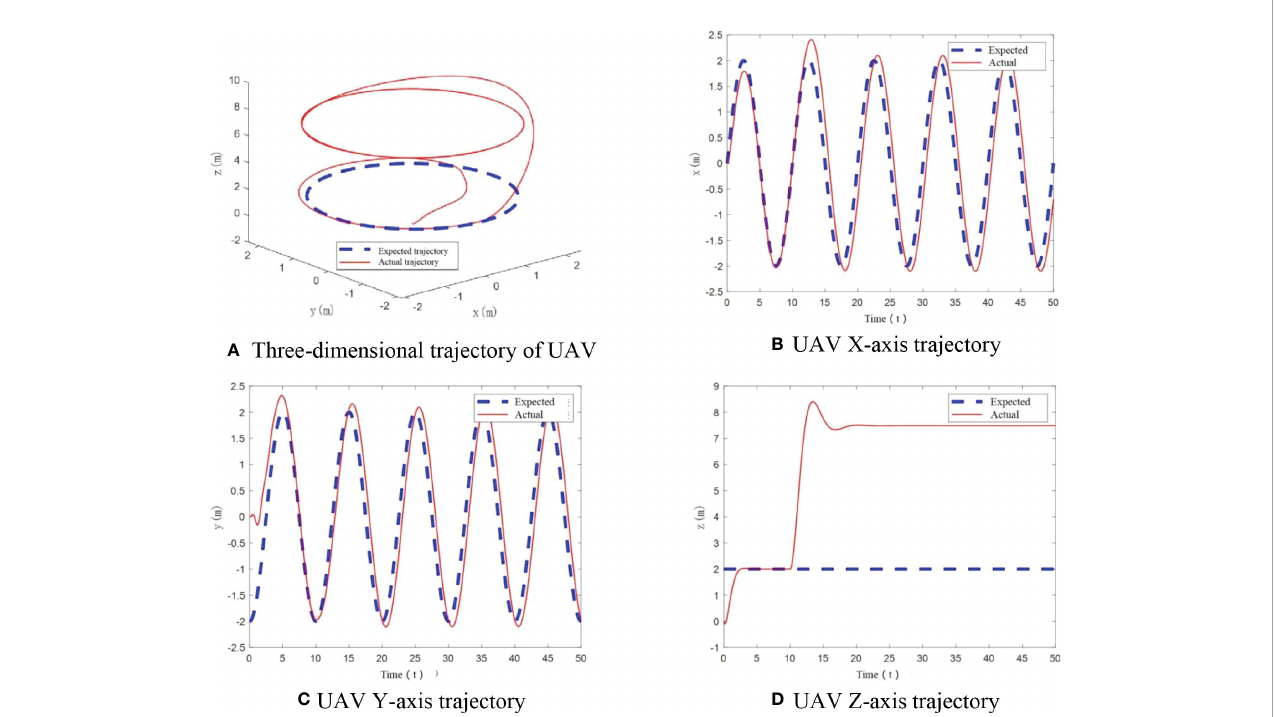
FIGURE 11 UAV fl ight trajectory with signi fi cant mass change. (A) Three-dimensional trajectory of UAV, (B) UAV X-axis trajectory, (C) UAV Y-axis trajectory, (D) UAV Z-axis